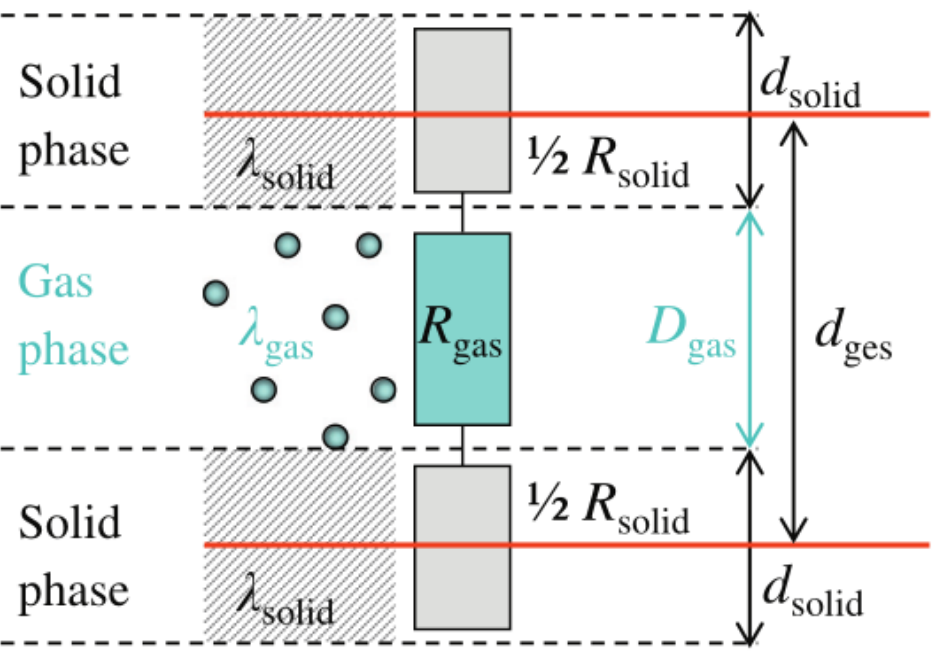
Figure 12. Resistance model [54].